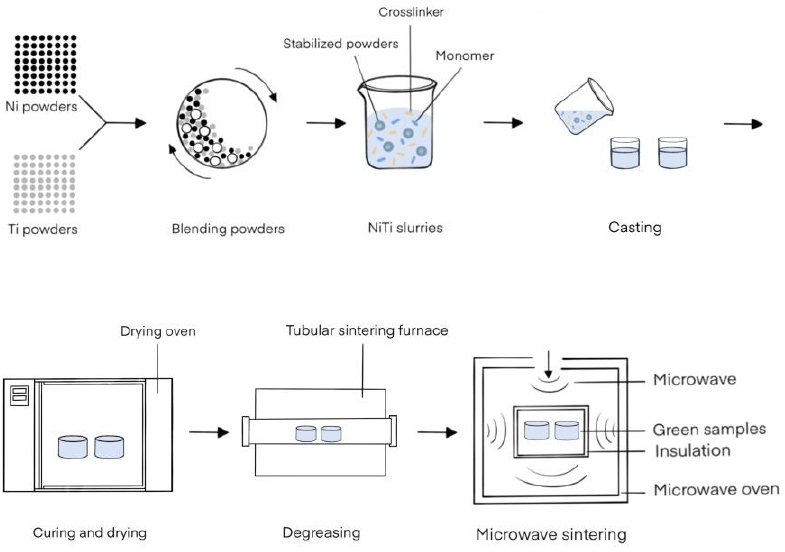
Figure 2. Gel-casting preparation procedure used for the NiTi alloy.